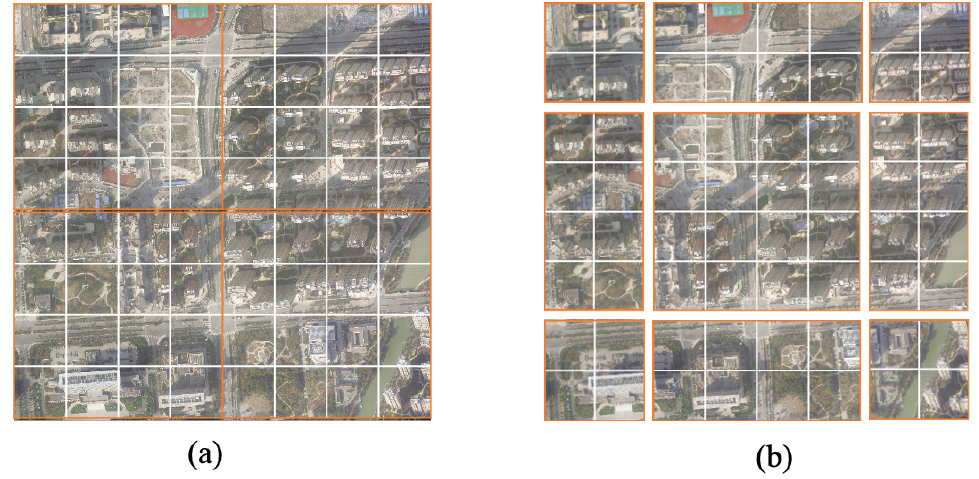
Figure 7. ( a ) Window partition strategy of W-MSA module; ( b ) window partition strategy of the SW-MSA